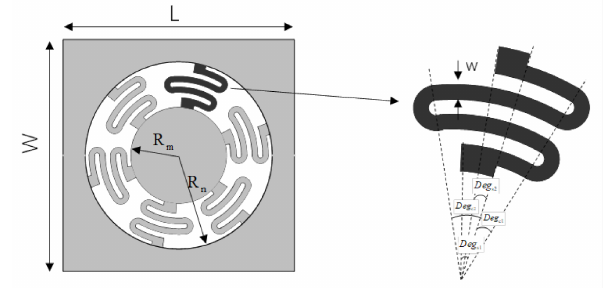
Figure 2. Structure of the spring-mass system.